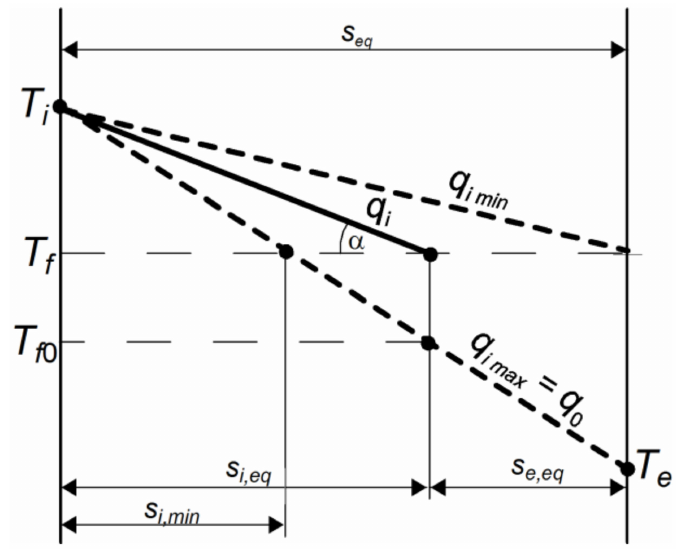
Figure 2. Envelope temperature